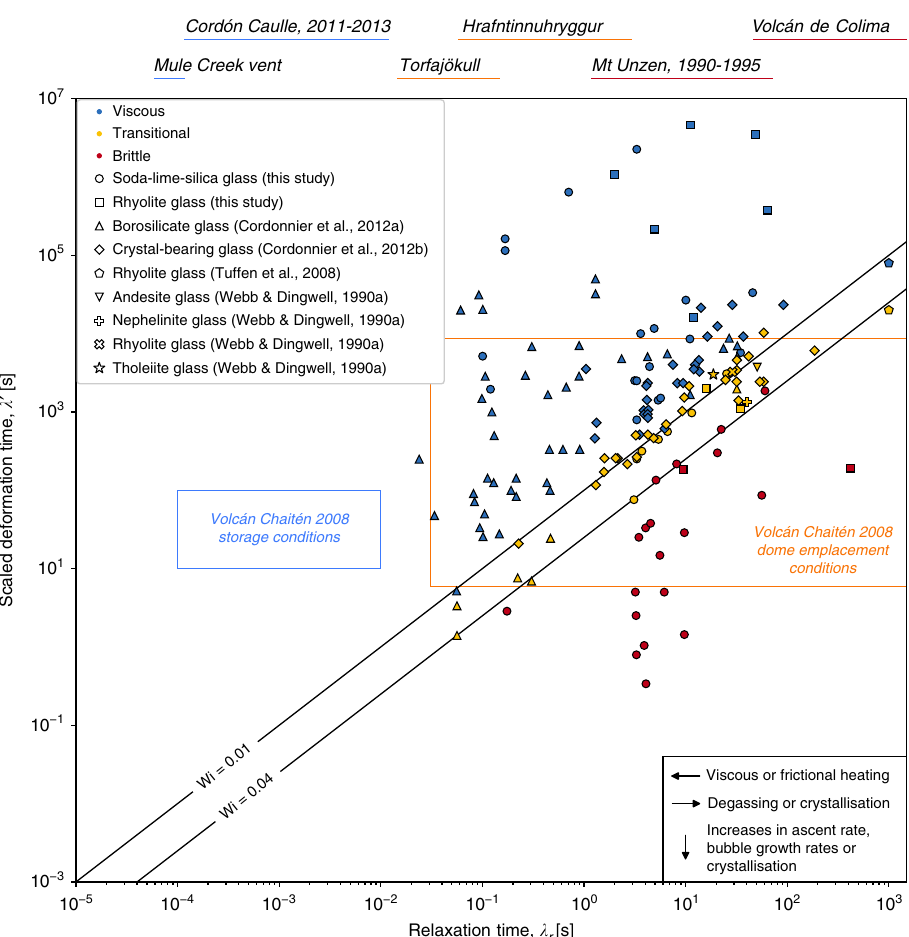
Fig. 4 The universal map for understanding the conditions under which multiphase magma will fracture. The data from Figs. 2 and 3 are compiled and repeated here where the multiphase data from Fig. 3 is rescaled to be uni fi ed with all single-phase data (see text). The boxes represent two constraints of the 2008 eruption of Volcán Chaitén where λ is calculated from estimates of magma ascent rate u assuming λ = L / u where L is the conduit radius 7 . The (cid:4) 4 wt.% ascending at 0.5 m s − 1 at T ~ 825 °C with no observable blue box is calculated using the storage and shallow ascent conditions of 1 (cid:4) C H 2 O (cid:4) evidence for brittle behaviour prior to fragmentation 7 and the yellow box is calculated using the range of sur fi cial dome lava conditions of 0 : 15 (cid:4) C H 2 O 0 : 4 wt.% 24 extruding at up to 0.1 m s − 1 vertically 41 and exhibiting mixed explosive-effusive behaviour. Conduit radius is 5 m in both cases. For comparison, we give the range of λ r for silica-rich aphyric and crystal-bearing magmas involved in a range of mixed explosive-effusive eruption styles. These ranges are grouped depending on whether λ r is estimated using hydrous storage conditions (black; Cordón Caulle, Mule Creek vent), degassed surface conditions (dark grey; Torfajökull, Hrafntinnuhryggur), or degassed crystal-bearing dome lavas (pale grey; Mt Unzen, Volcán de Colima). The 2011 – 2013 eruption of (cid:4) 4 : 5 wt.% at storage conditions of T ~ 896 °C 20 . The Mule Creek vent obsidian has estimated 2 : 5 (cid:4) Cordón Caulle involved magma with 2 : 5 (cid:4) C H 2 O C (cid:4) 3 wt.% emplaced at T ~ 800 °C 14 . The Torfajökull obsidian (Bláhnúkur) preserves low 0 : 27 (cid:4) C (cid:4) 0 : 58 wt.%, and was emplaced at H 2 O H 2 O T ~ 800 °C 15 . The 1990 – 1995 dome-forming magma from Mt Unzen erupted nominally dry at 780 ≤ T ≤ 880 °C with crystallinities 0.25 < ϕ x < 0.5 39 . The Þ are dome magma at Volcán de Colima erupted nominally dry at T ~ 940 °C with 0.4 < ϕ x < 0.6 40 . In all cases, rhyolitic liquid viscosities μ ð T ; C H 2 O computed 31 with the additional scaling with (1 − ϕ x / ϕ m ) − 2 where appropriate using Mueller et al. 38 and a smooth crystal aspect ratio of 2, and converted to λ r or λ ′ r by taking μ / G ∞ or η / G ∞ ,